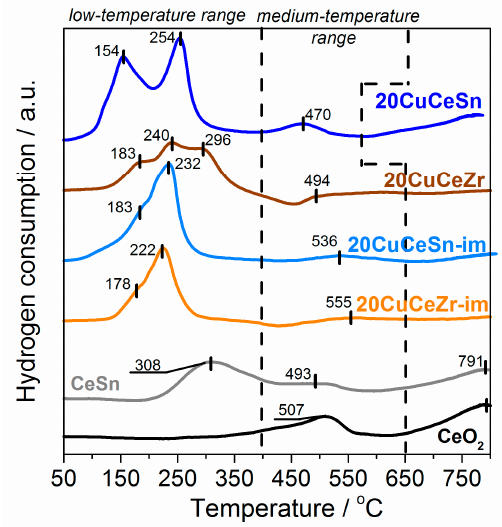
Figure 4. H 2 -TPR profiles of 20CuCeSn, 20CuCeZr, 20CuCeSn-im and 20CuCeZr-im catalysts and reference CeSn and CeO 2 samples.